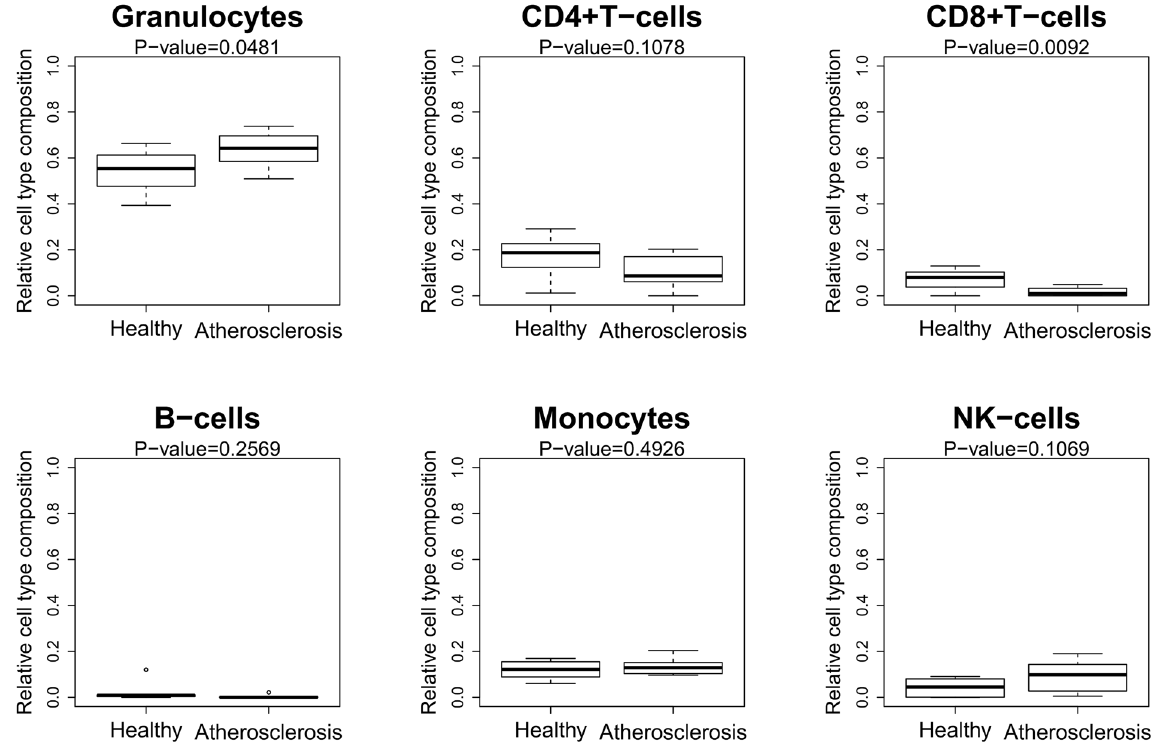
Figure 5. Deconvolution of immune cell type blood composition. The approach described by Houseman et al . was applied to determine the relative immune cell type fraction (Y-axis) in healthy and atherosclerosis blood samples. Statistical significant differences in cell type contribution between healthy and atherosclerosis blood samples were calculated by a student